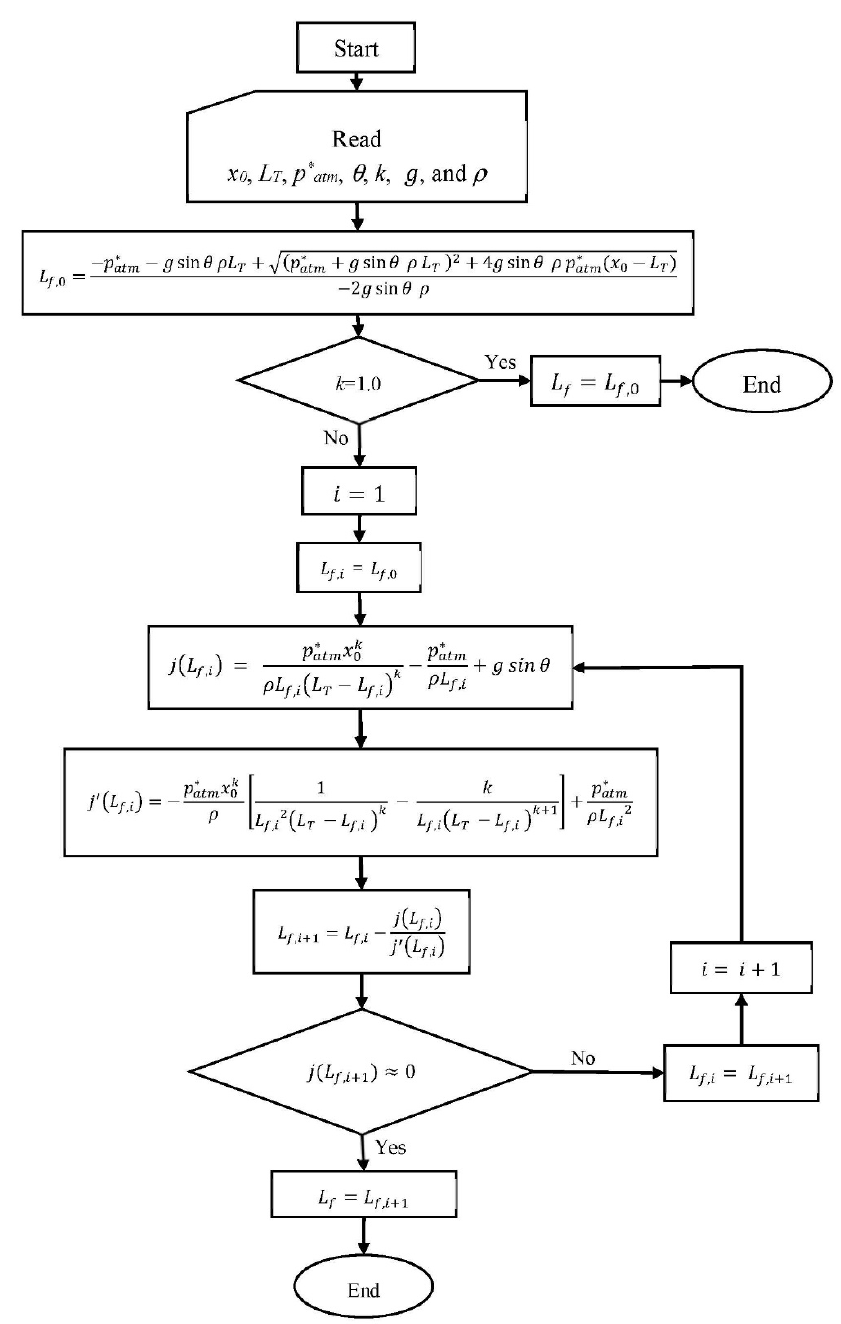
Figure 2. Flowchart for computing final conditions in a single water emptying pipeline .